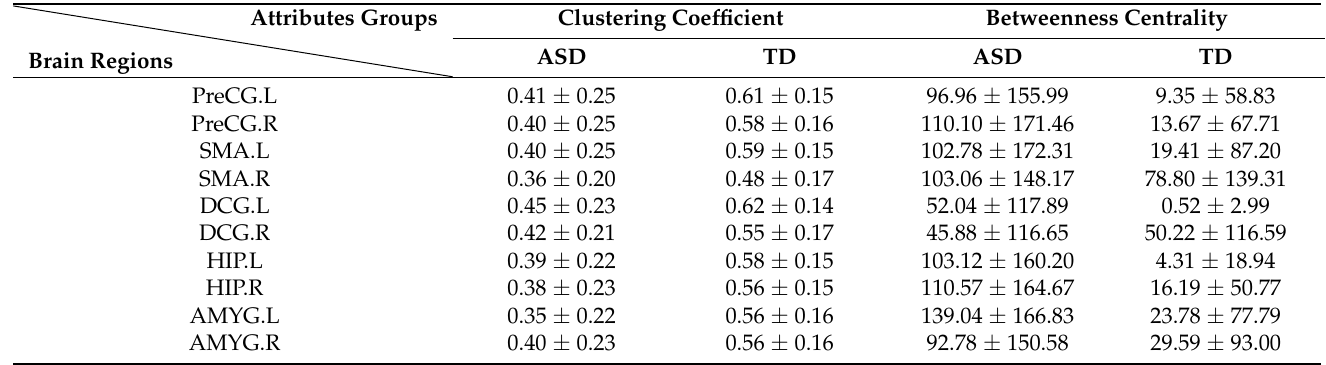
Table 2. Clustering coefficients and betweenness centrality of 24 social-related brain regions in the ASD and TD